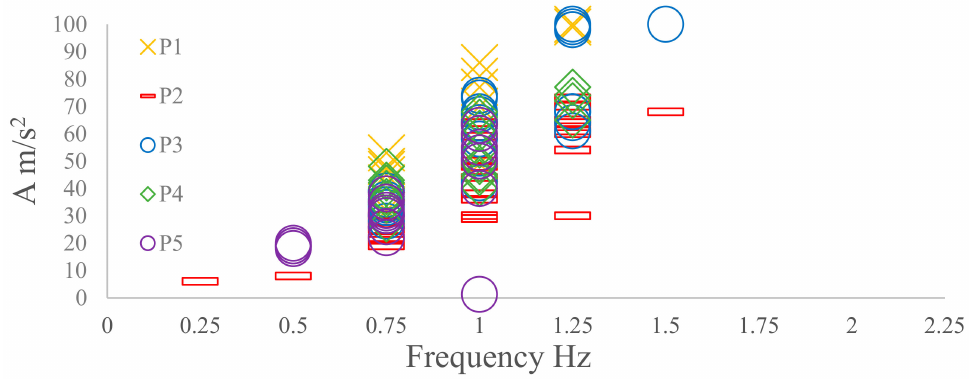
Figure 9. Five participants with di ff erent age groups and